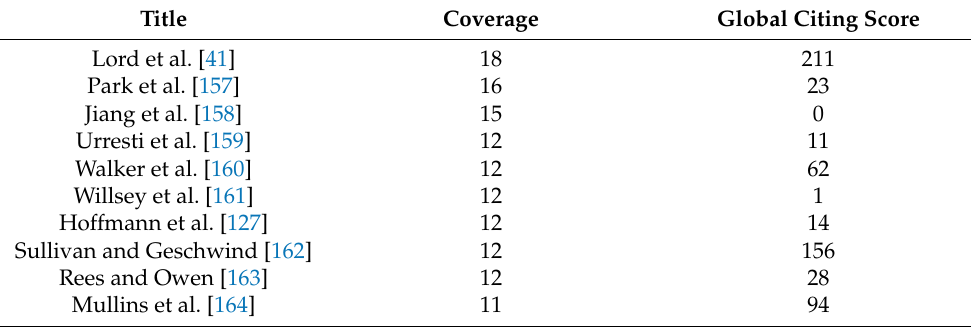
Table 10. Top 10 citing papers in Cluster #7 identified using